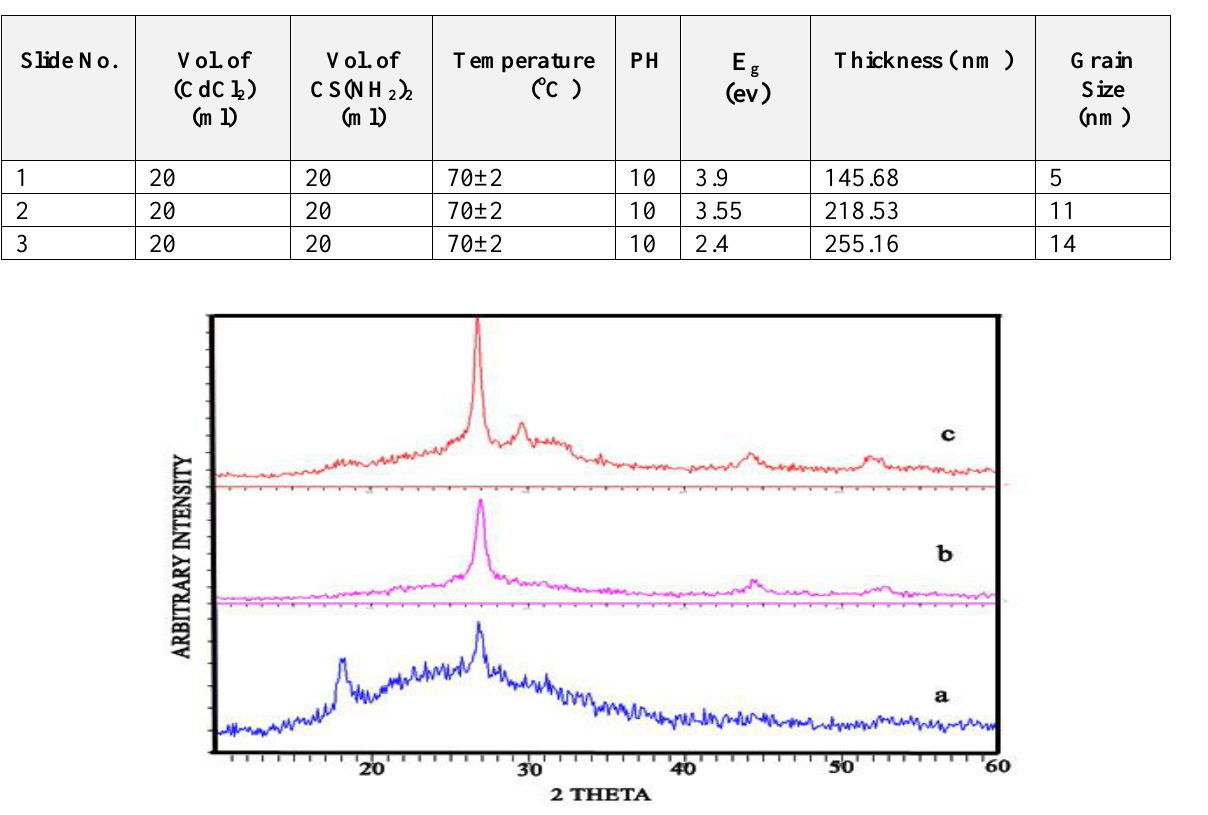
Fig. 1: X-ray diffraction patterns of the three CdS thin films deposited on glass substrate. (a) one deposition (b) double deposition (c) triple deposition.